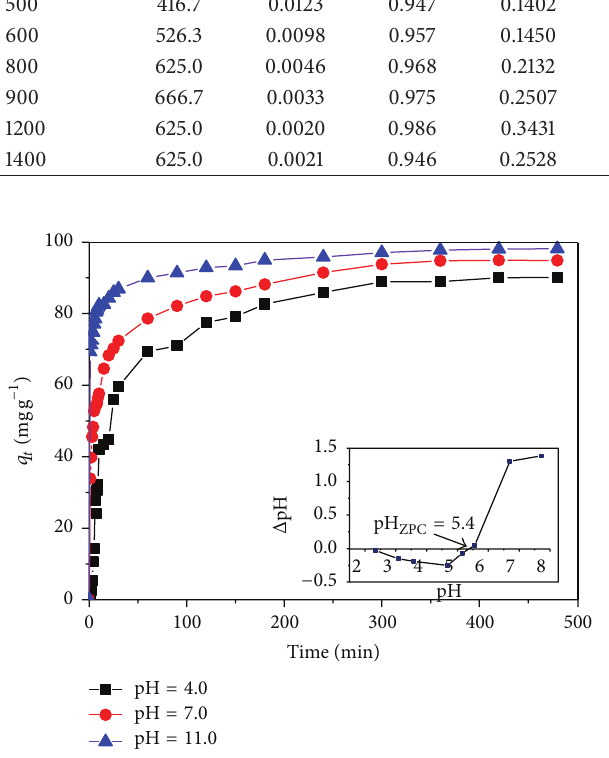
Figure3:ThepHeffectontheABadsorptionfromaqueoussolution by diatomite. Adsorption condition: initial AB concentration = 200 mg L −1 ,massofadsorbent=2.0 g,volumeofsolution=1000 mL, and stirring speed = 300 rpm. The plot of Δ pH versus initial pH